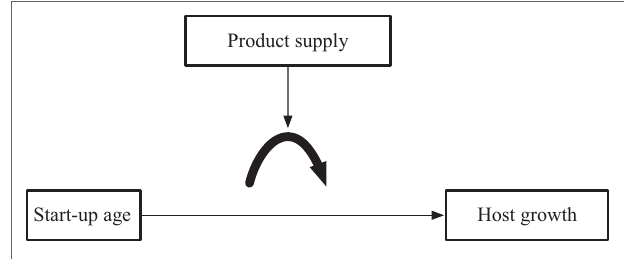
FIGURE 1 | The hypothesized